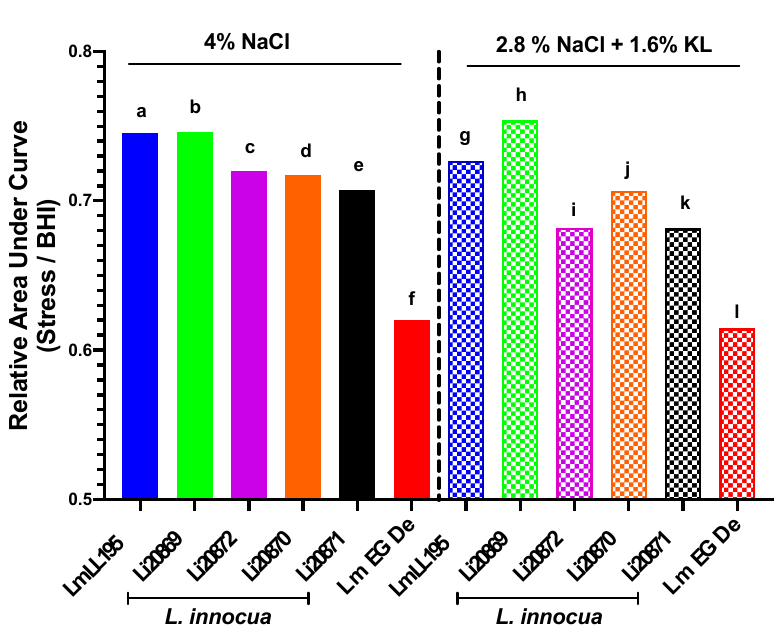
Figure 2. The selected L. innocua surrogate strains display similar stress response behavior to L. monocytogenes during growth in BHI supplemented with 4% NaCl or the 2.8% NaCl plus 1.6% KL combination. GraphPad Prism generated data represent relative area under the curve (AUC) derived from growth curves of L. monocytogenes (LL195 and EGDe) and L. innocua ( Li 20869, Li 20870, Li 20871, and Li 20872) strains grown in normal BHI vs. growth under stress (BHI supplemented with 4% NaCl or 2.8% NaCl plus 1.6% KL). Each mean AUC per strain and treatment was expressed relative to those of the control with no stressor added. Based on the AUC, the selected L. innocua strains distributed within the range of low (EGDe) to high (LL195) osmotolerant L. monocytogenes strains. Different letters indicate a significant difference between the strains and treatments ( p < 0.05 based on one-way ANOVA and Tukey post-hoc test pairwise